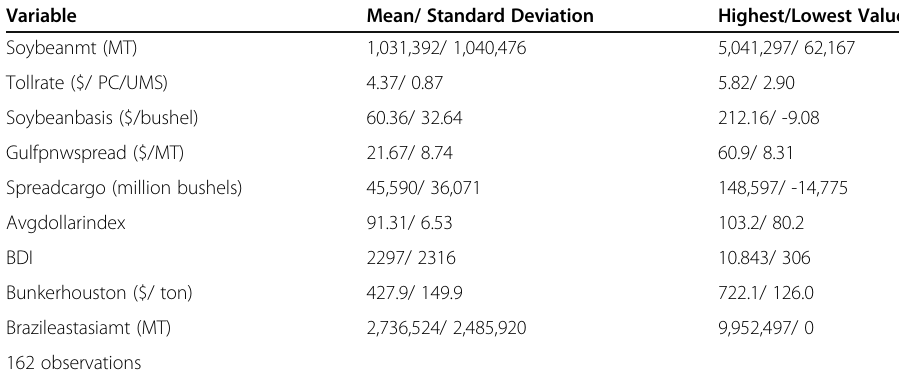
Table 2 Descriptive statistics for monthly and monthly- transformed data Variable Mean/ Standard Deviation Highest/Lowest Value Soybeanmt (MT) 1,031,392/ 1,040,476 Tollrate ($/ PC/UMS) Soybeanbasis ($/bushel) Spreadcargo (million